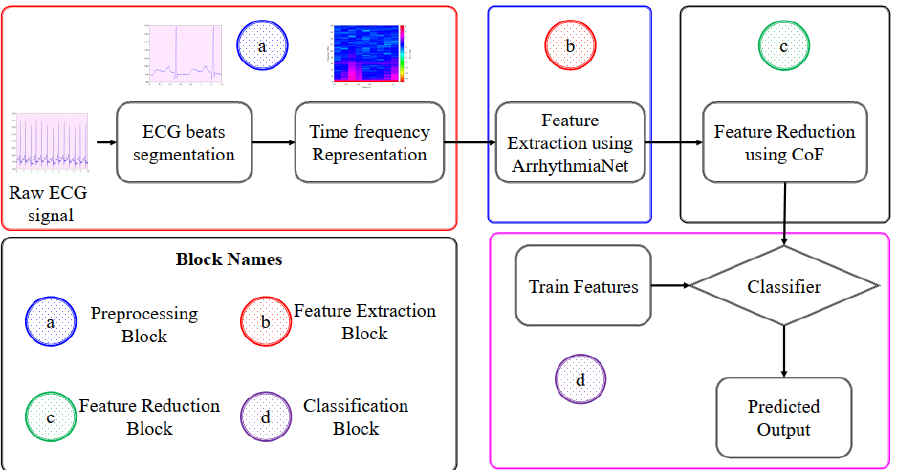
Figure 2. Block diagram of the proposed framework.